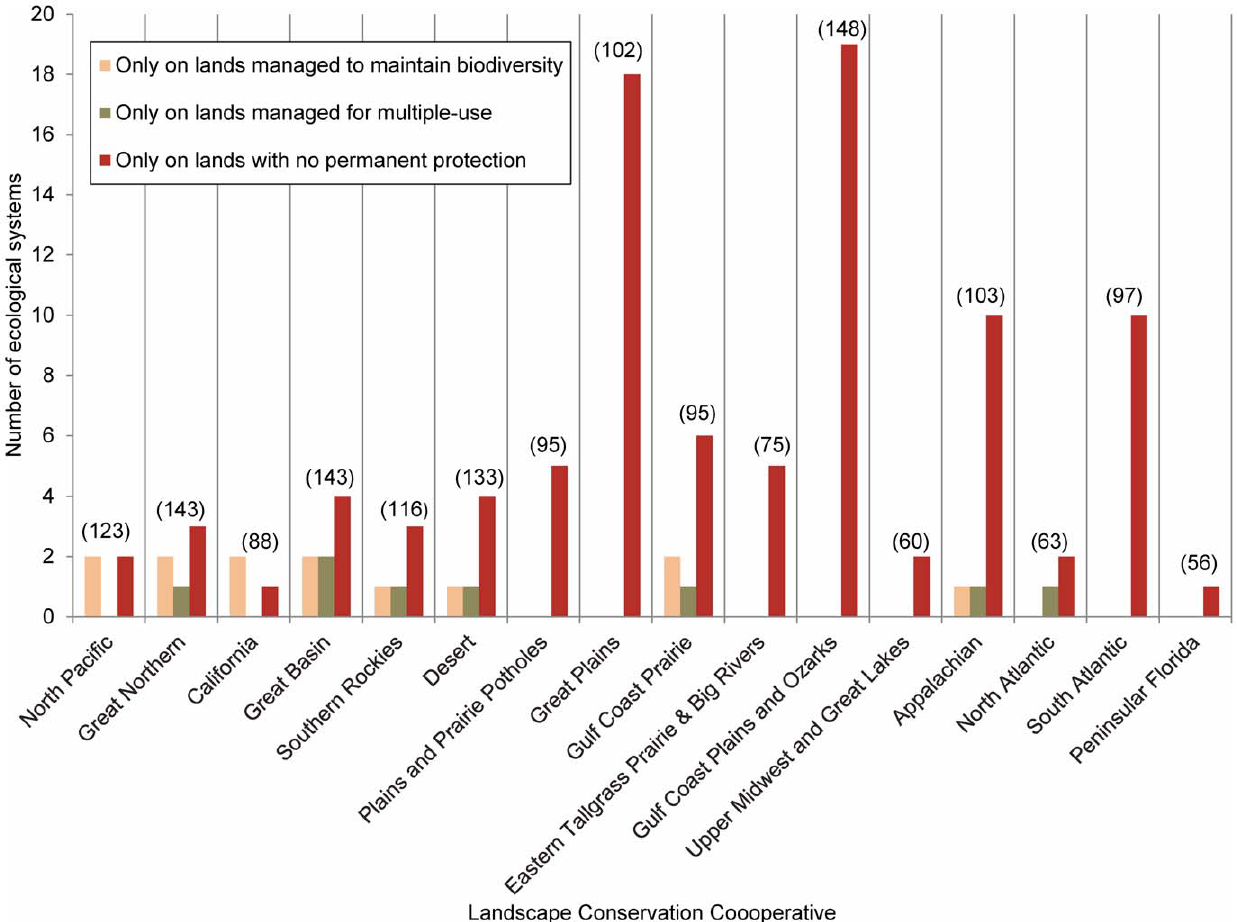
Figure 7. Number of ecological systems occurring only within each protection status by Landscape Conservation Cooperative (LCC). Ecological systems included occur only within the specified protection status [23,24]. The total number of ecological systems within each LCC is shown parenthetically. For example, the Great Plains LCC contains 102 ecological systems with 18 occurring only on lands with no permanent protection and none occurring on lands managed to maintain biodiversity or for multiple-use. See Table 1 for protection status descriptions. Only non-modified, non-aquatic ecological systems are included (n=518; Table S1).